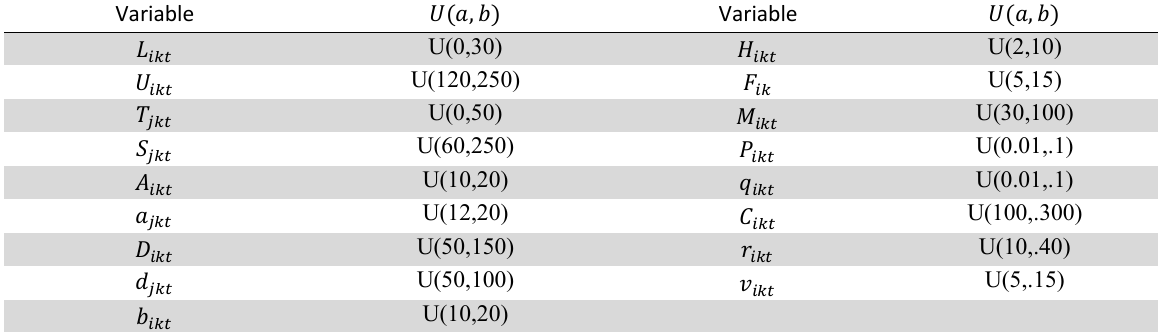
The summary of parameters set for GA method